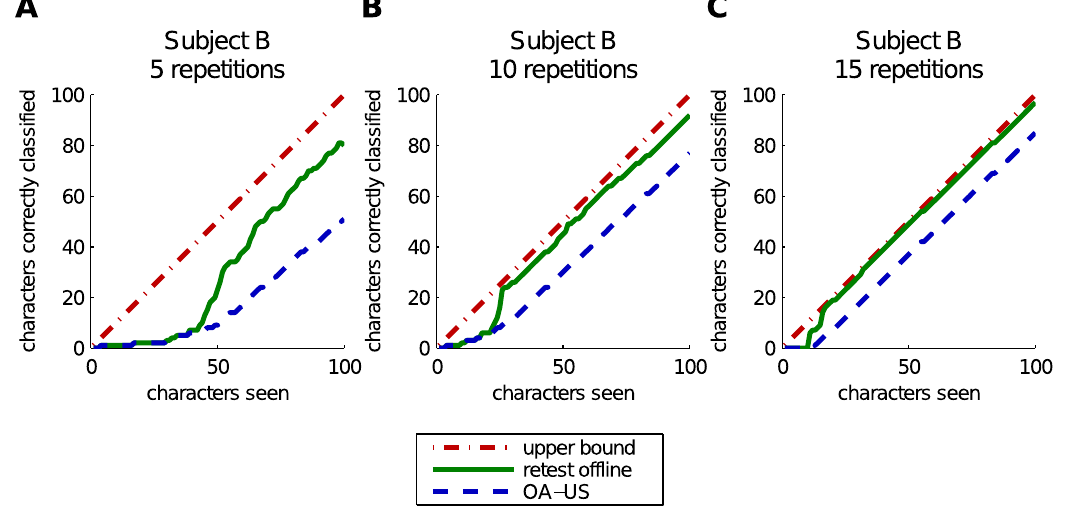
Figure 7. Plots showing the performance obtained by 3 single online initializations on subject B, each using a different number of repetitions to predict a character. The horizontal axis represents the number of characters processed. The vertical axis represents how many of these characters were predicted correctly. The dashed line shows us how many characters the online classifier has predicted correctly (starting with an initially untrained classifier). The solid line shows how many characters the current classifier can predict correctly if we re-test it on all of the previously processed characters. The dash-dot line represents the upper bound on the performance which equals the number of characters seen.